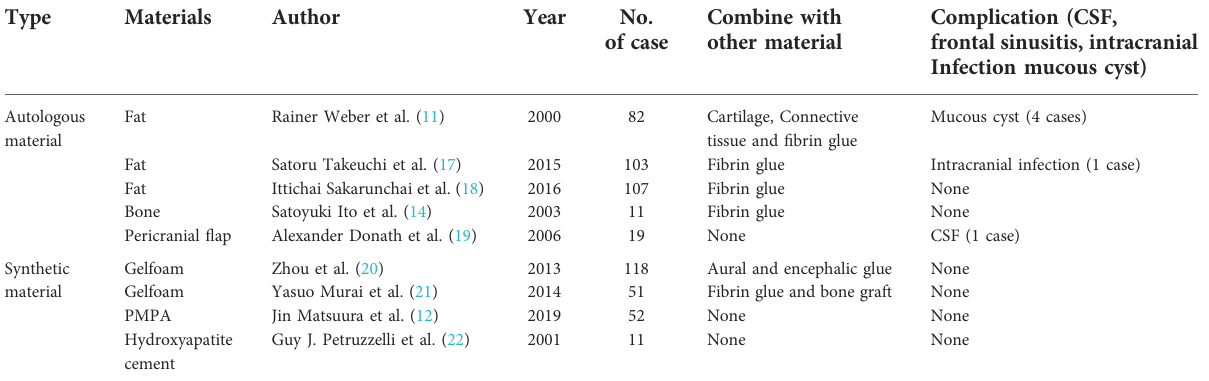
TABLE 2 Frontal sinus reconstruction methods with large series